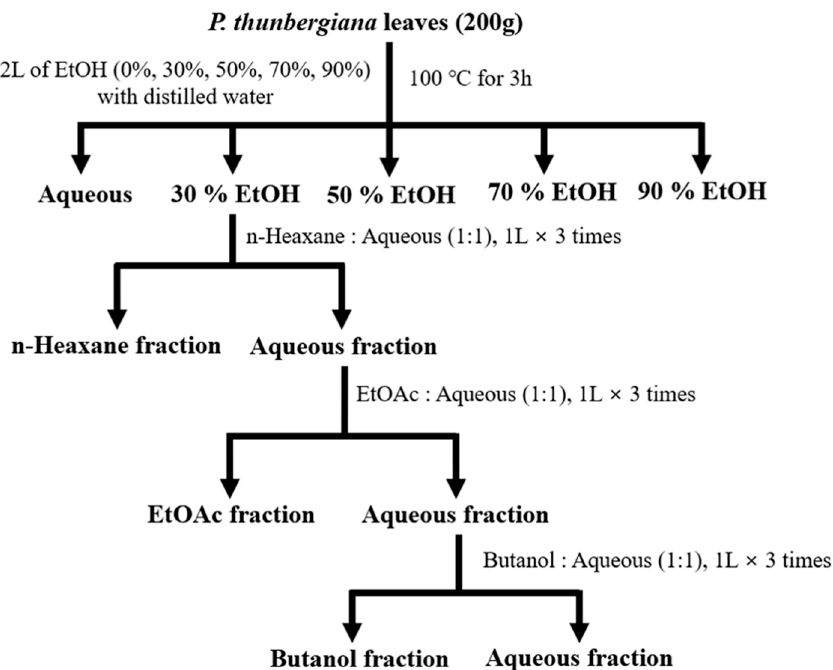
Figure 1. Extraction and division of fractions from P . thunbergiana L.